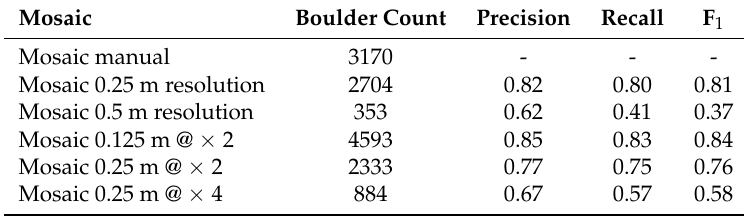
Table 1. Precision, accuracy and F 1 score (macro-average) for boulder densities displayed in Figure 5.